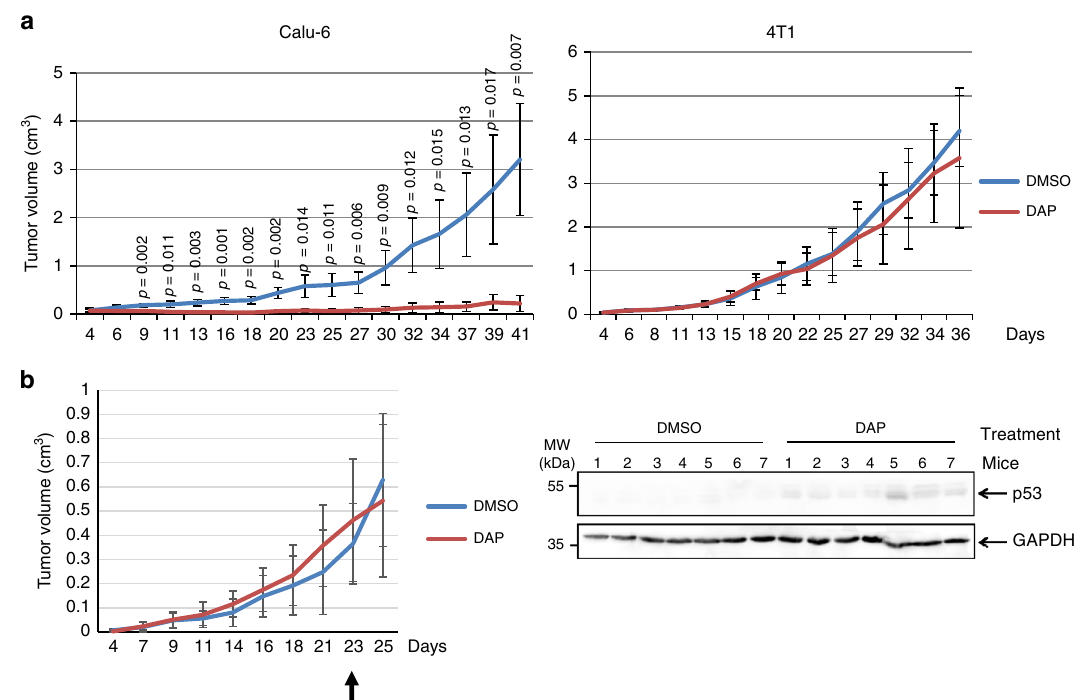
Fig. 4 DAP corrects UGA nonsense mutations in vivo. a Twenty-eight nude mice were injected with Calu-6 or 4T1 cells to promote tumor development. The mice were exposed to DMSO or DAP for about 5 weeks and tumor size was measured at different time after cell injection and plotted on the graph. For each experimental condition, 7 mice were used. b Fourteen nude mice were injected with Calu-6 cells to promote tumor development. The mice were exposed to DMSO or DAP when the average tumor size reached about 0.4 cm 3 . The arrow indicates the starting time of the exposure to DMSO or DAP. For each experimental condition, 7 mice were used. The tumor growth curve is presented on the left, and the right panel shows the western-blot analysis of p53 protein in the Calu-6-cell tumors of the seven DMSO-exposed and seven DAP-exposed mice. GAPDH was used as loading control. A molecular weight marker is indicated to the left of the gel. The results presented in this fi gure are representative of two independent experiments. p -values ( p ) were calculated using Student ’ s t -test. Source data are provided as a Source Data fi